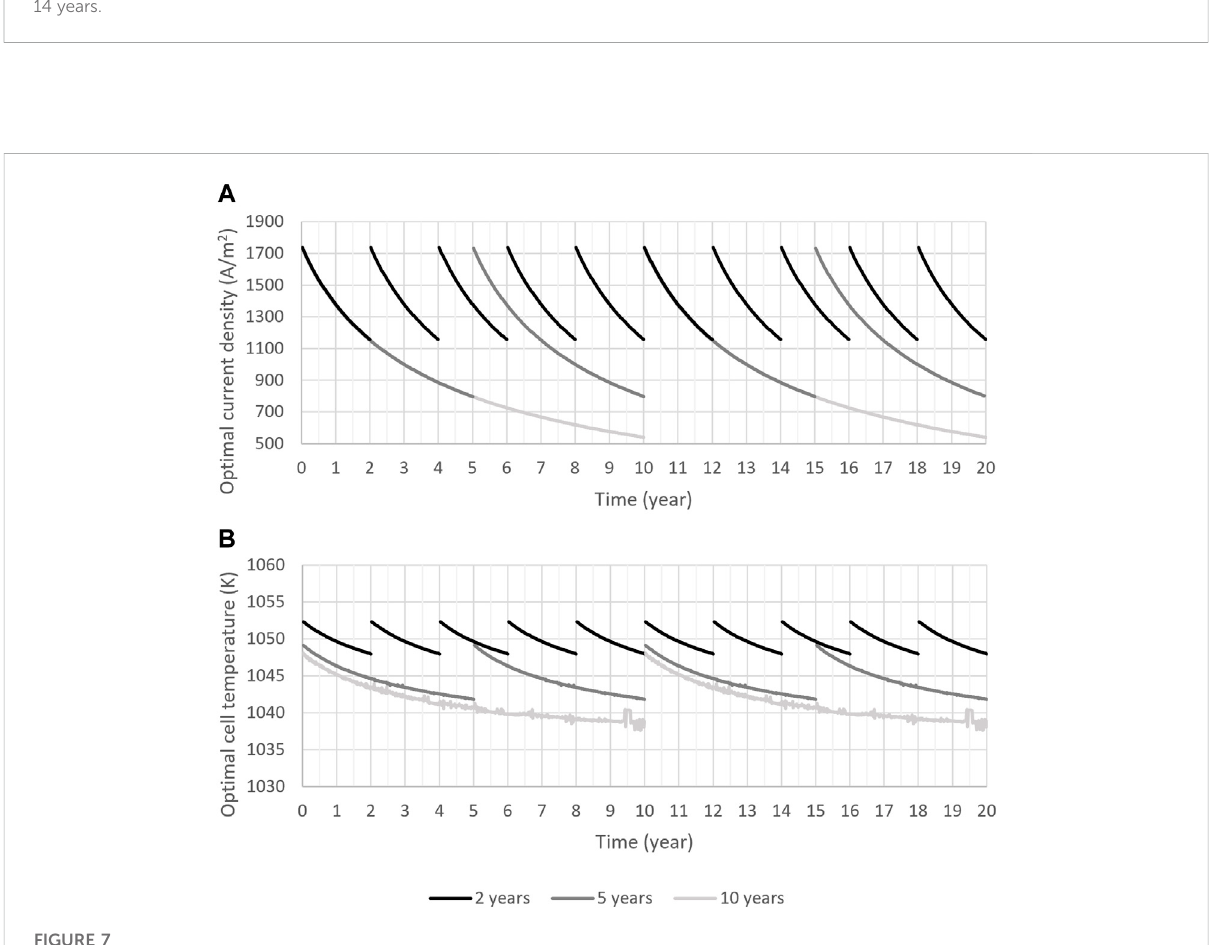
FIGURE 7 Trajectoriesof (A) optimalcurrentdensityand (B) optimaltemperatureofSOECswith2-,5-,and10-yearreplacementschedulesovera20-year project